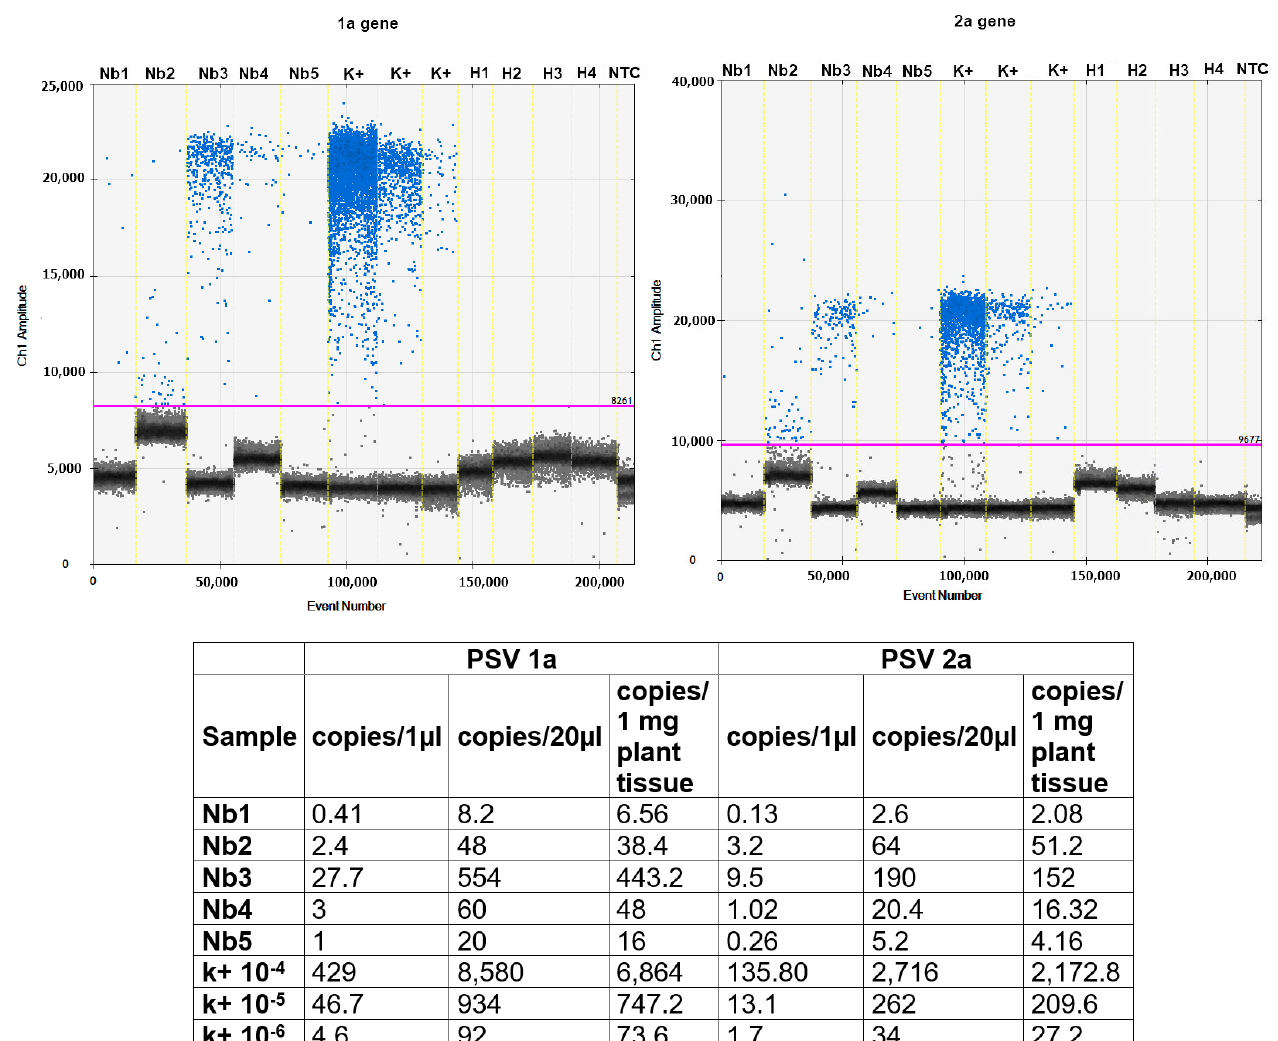
Figure 6. The ddPCR detection of viral 1a and 2a genes in N. benthamiana plants after inoculation with PSV-exposed larvae. ( Upper ) 1-D plot diagrams present differences in amplitudes of fluorescence signals between positive and negative droplets for 1a ( left ) and 2a ( right ). The black droplets represent negative droplets with no templates, and blue represent positive droplets containing amplified templates; pink line: threshold separating negative from positive droplets. Nb1–Nb5 samples of tested plants inoculated with the viruliferous insect; H1–H4 healthy plants of N. benthamiana ; K(+) positive controls cDNA from PSV infected plants (10—fold diluted, 1 × 10 − 4 , 10 − 5 , 10 − 6 ); NTC—no template control. ( Below ) The EvaGreen ddPCR absolute quantification of copies number of PSV 1a and 2a genes per 1 µ L of ddPCR reaction mixture, in 20 µ L of the reaction mixture and the equivalent of copy number of viral RNA1 and RNA2 per 1 mg of plant tissue.